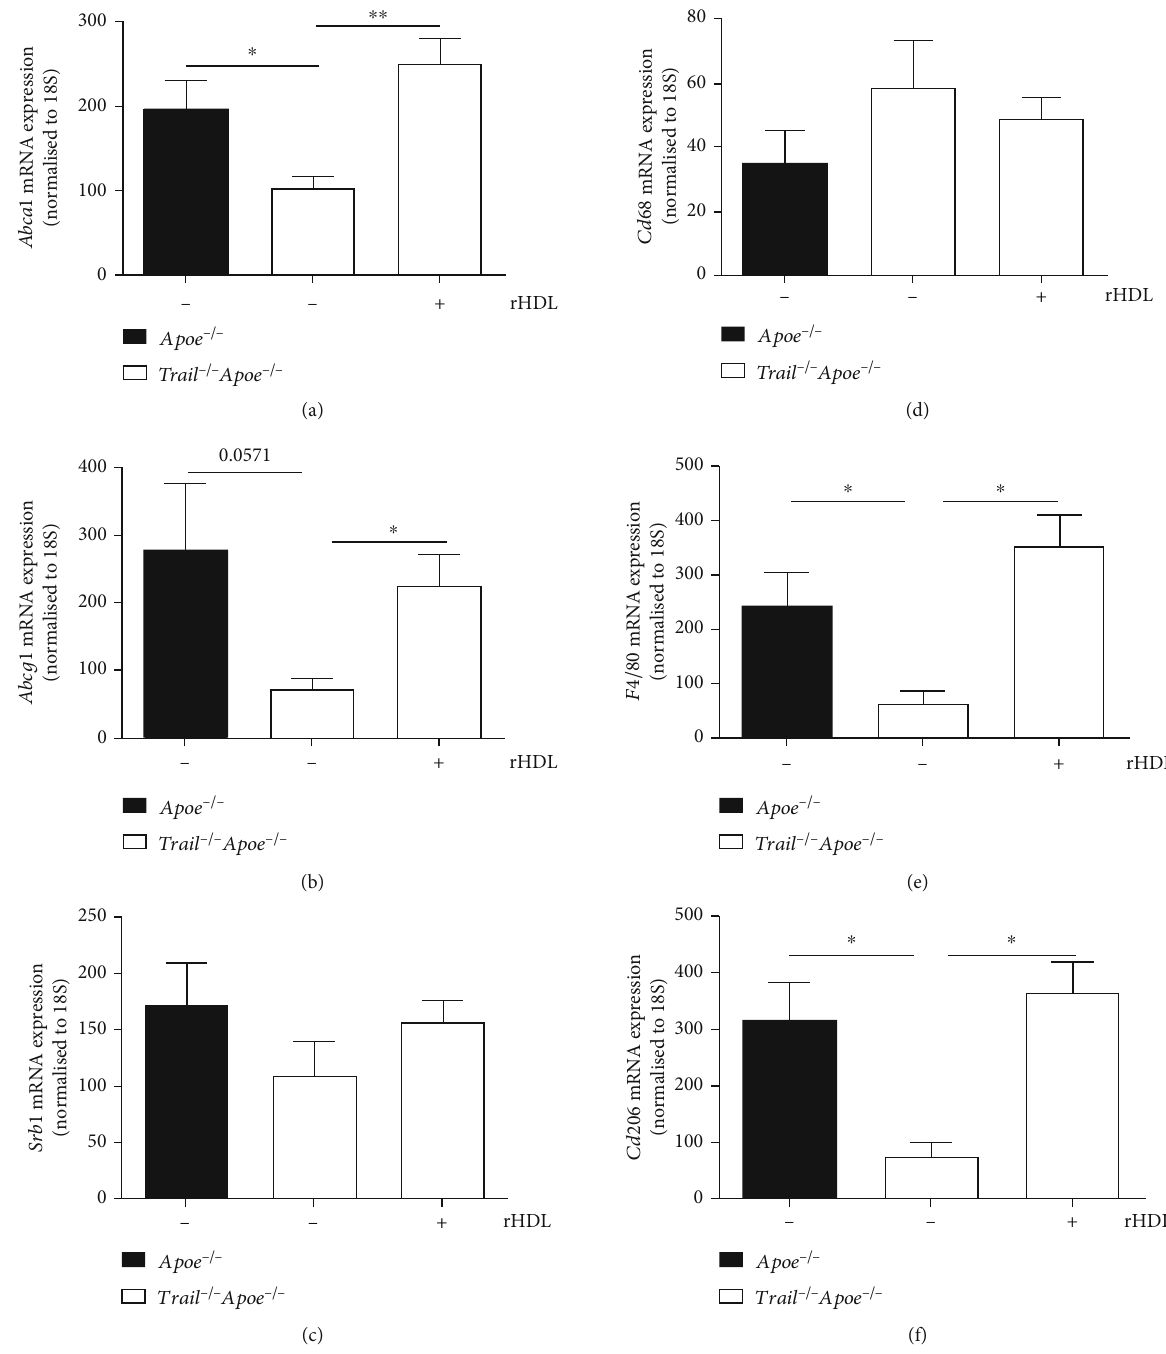
Figure 4: rHDL alters expression of genes regulating cholesterol metabolism and in fl ammation. Trail -/- Apoe -/- and Apoe -/- mice were fed a high-cholesterol diet for 12 weeks. In the last 2 weeks of the study, mice received 3 weekly infusions of either rHDL (20 mg/kg) or PBS. (a) Abca1 , (b) Abcg1 , (c) Srb1 , (d) Cd68 , (e) F4/80 , and (f) Cd206 mRNA expression in aortae. Aortae were isolated and mRNA extracted as described in Methods. mRNA expression was normalised to 18S ( n = 4 -6/group). Results are expressed as mean ± SEM ; ∗ p < 0 : 05 and ∗∗ p < 0 : 01 , ANOVA used in all conditions. rHDL: reconstituted high-density lipoprotein; Apoe: apolipoprotein E; TRAIL: TNF-related apoptosis-inducing